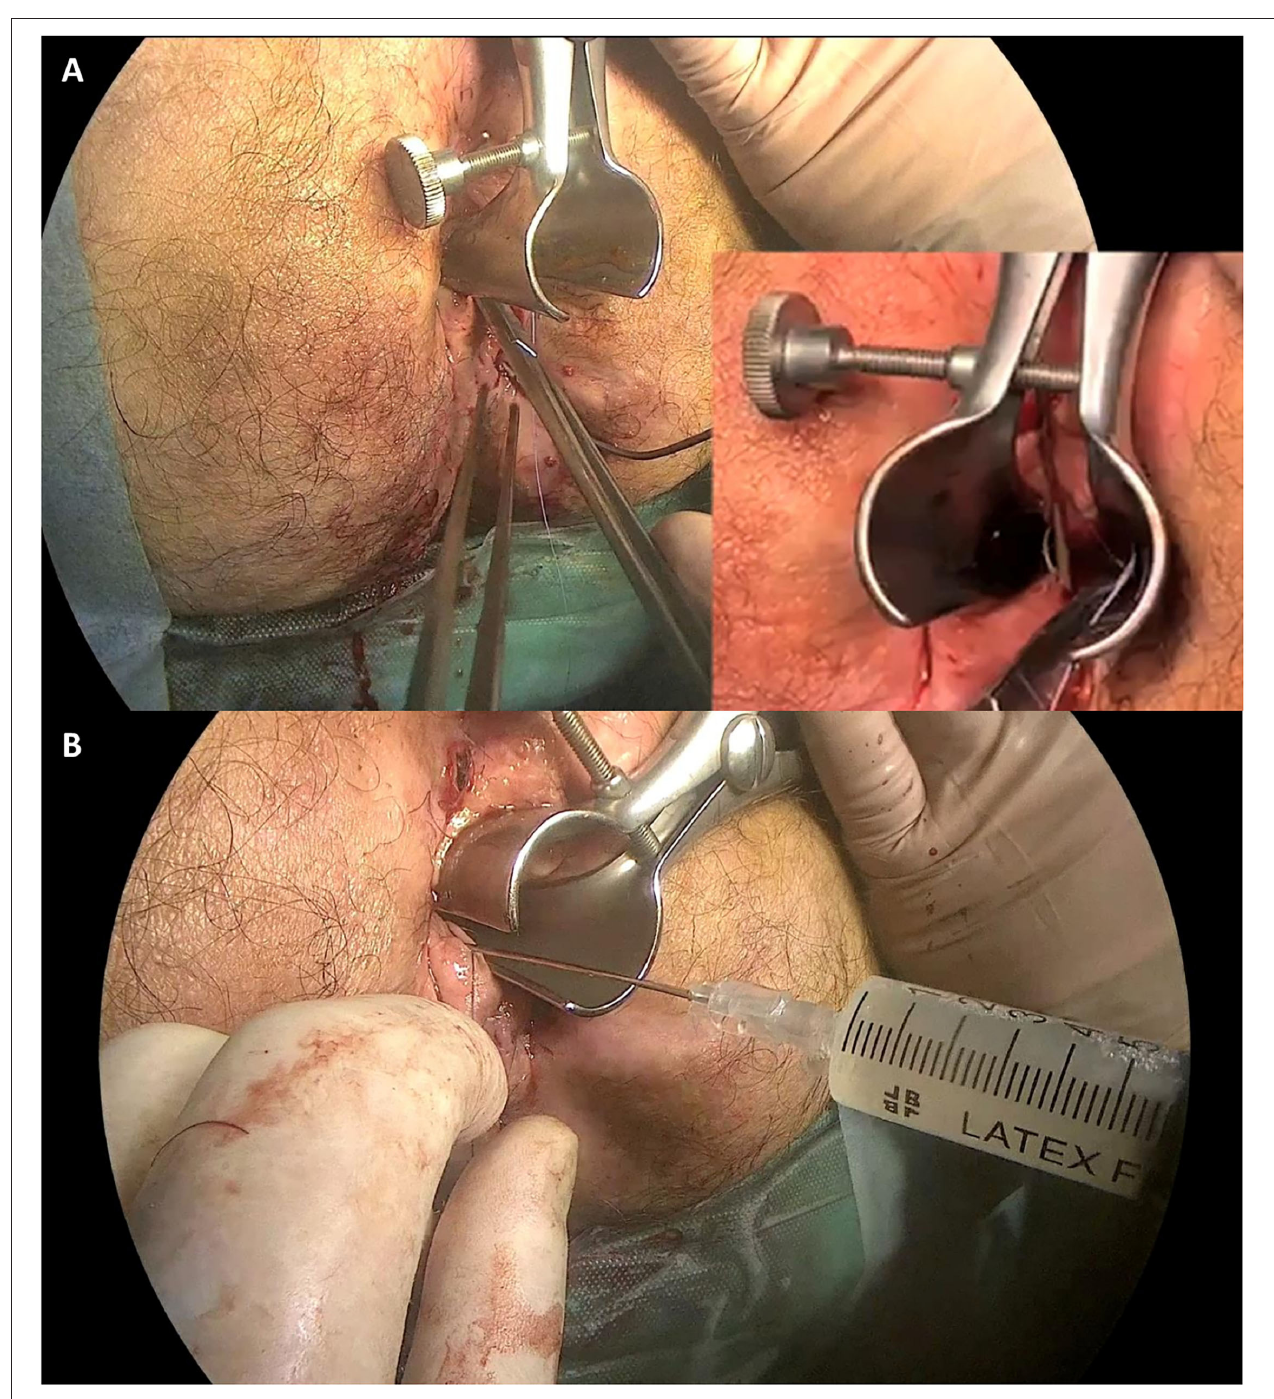
FIGURE 1 | Surgical procedure. Panel (A) shows the fistula’s internal orifice closure with a 2/0 absorbable stitch. Panel (B) shows the stem cell (Darvadstrocel) injection in the tissue around the internal orifice and through the external orifice into the fistula walls.